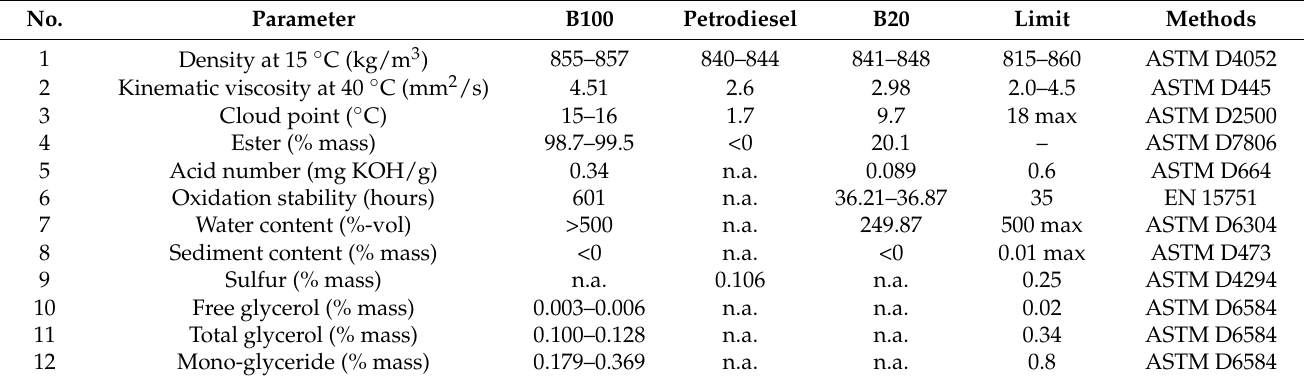
Table 2. Properties of biodiesel (B100), petrodiesel (B0), and blended (B20)